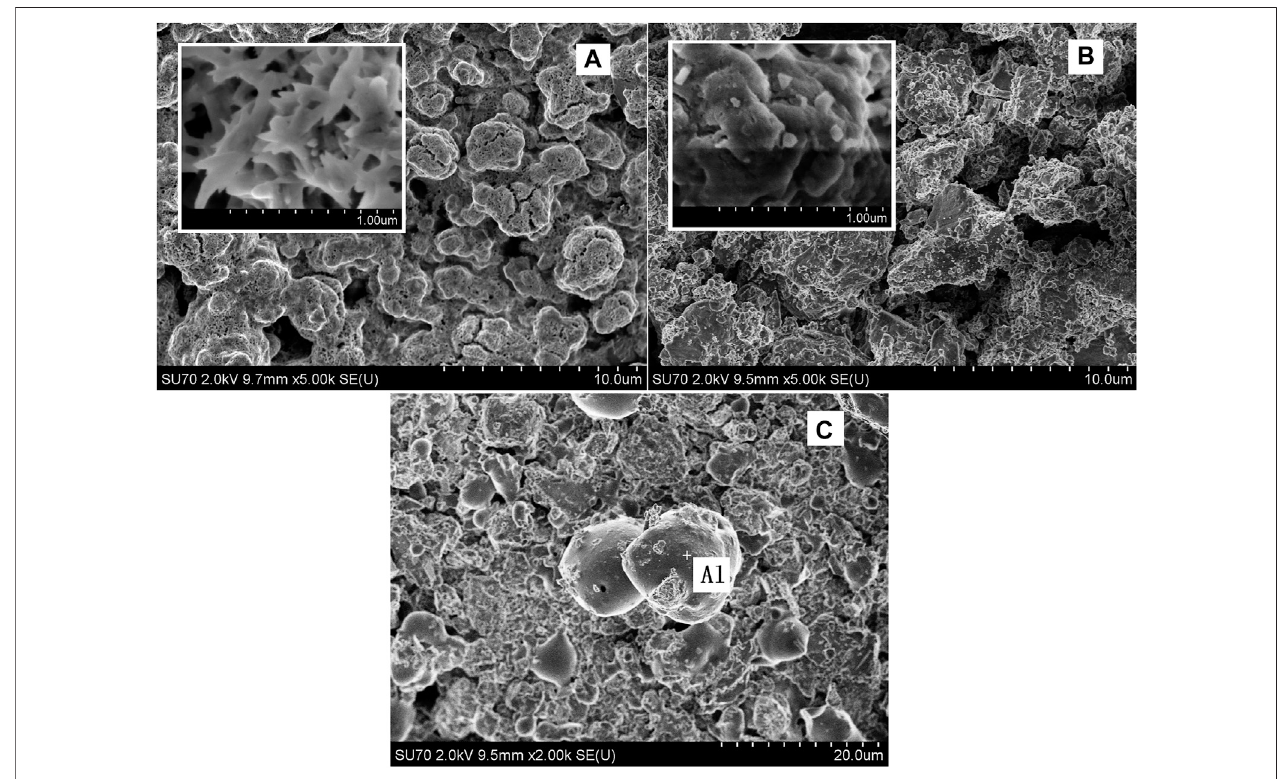
FIGURE 10 | SEM images of the 2LiBH 4 – Li 3 AlH 6 composites: (A) ball-milled sample, (B) sample after fi rst dehydrogenation cycle, and (C) sample after second dehydrogenation cycle with 3 bar back